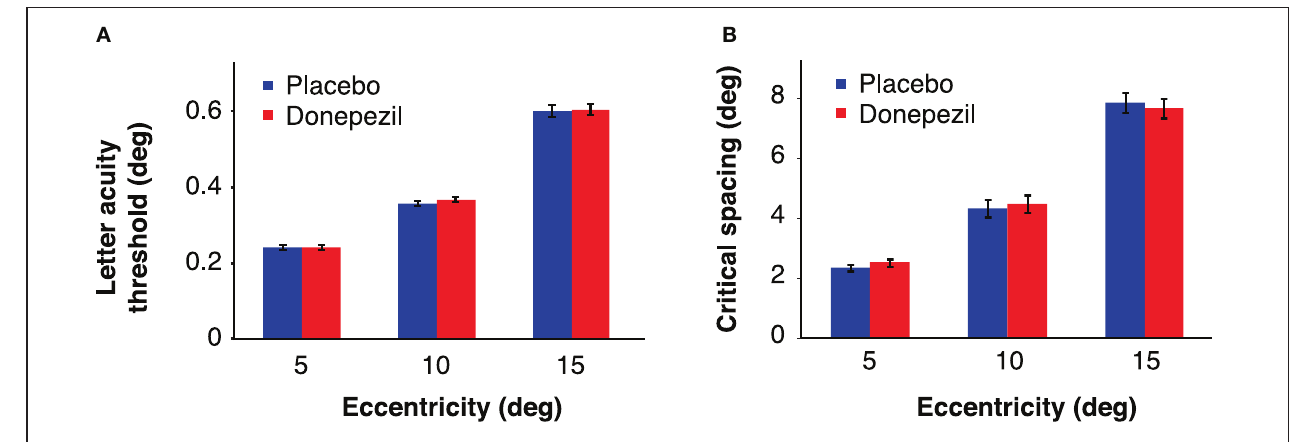
FIGURE 5 | Letter acuity thresholds (A) and critical spacing thresholds (B), defined as the letter size (acuity task) or the critical spacing (crowding task) corresponding to 80% correct performance. Donepezil